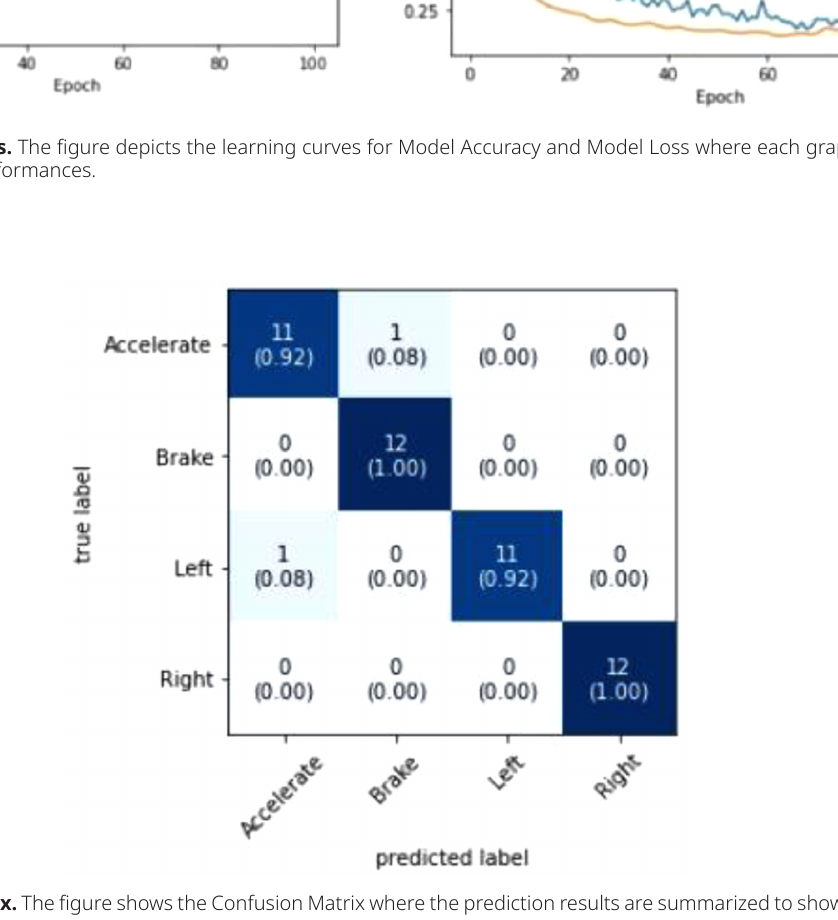
Figure 6. Confusion Matrix. The figure shows the Confusion Matrix where the prediction results are summarized to show the performance of the model.